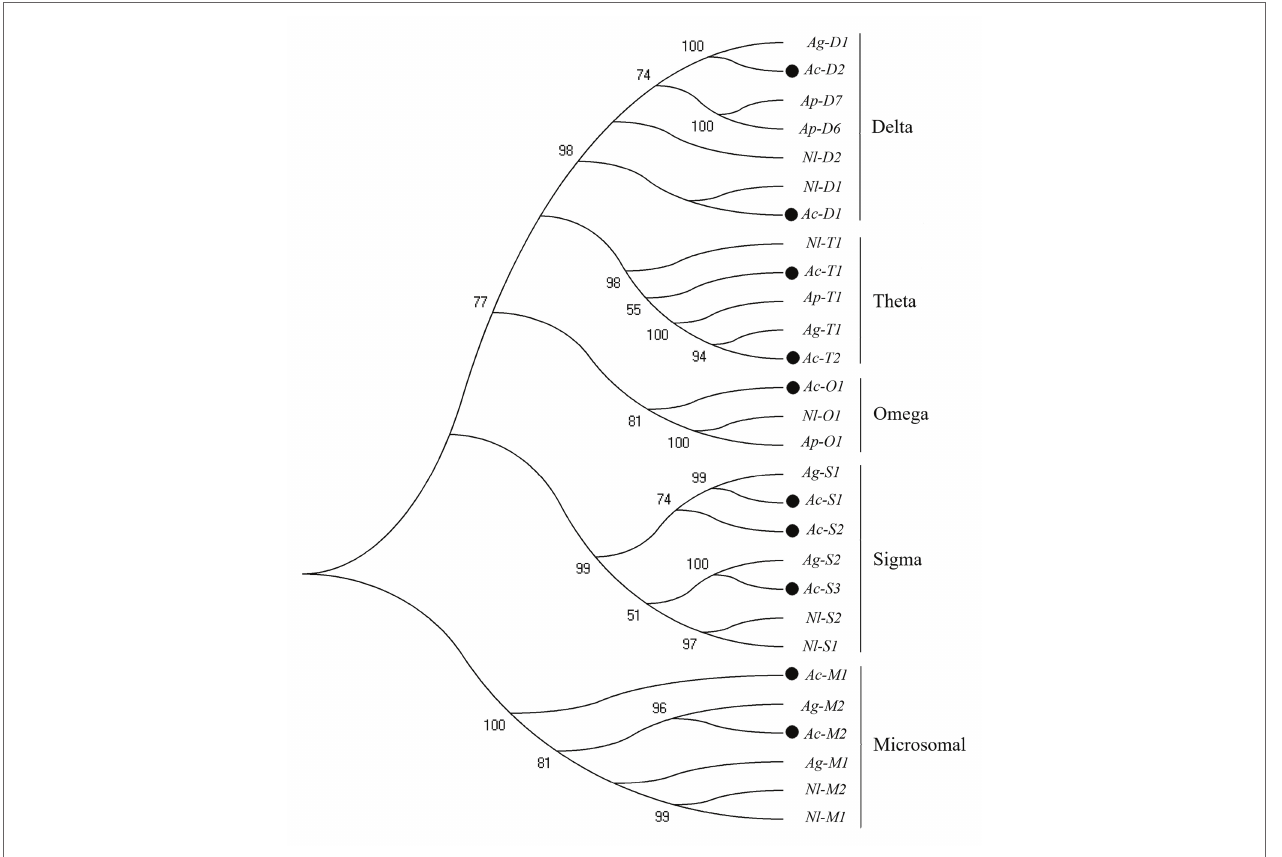
FIGURE 2 | Phylogenetic analysis of GST genes. The numbers above the branches indicate the support for the phylogenies, and only values above 50% are shown. Blackened circles indicate the A. craccivora position. Ac, A. craccivora ; Ag, Aphis gossypii ; Ap, Acyrthosiphon pisum ; Nl, Nilaparvata lugens